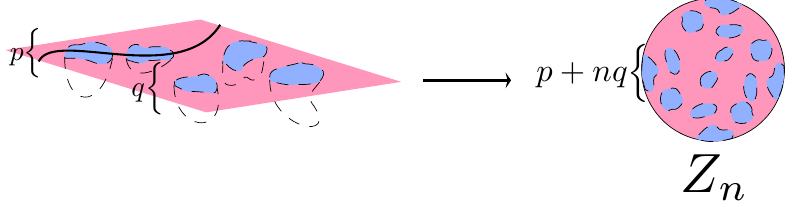
Figure 15 . (Left) The state on the plane has p + q interfaces, and we take the entangling surface to pass through p of them transversely. The replica manifold (Right) is easy to describe as a three-sphere with p + nq